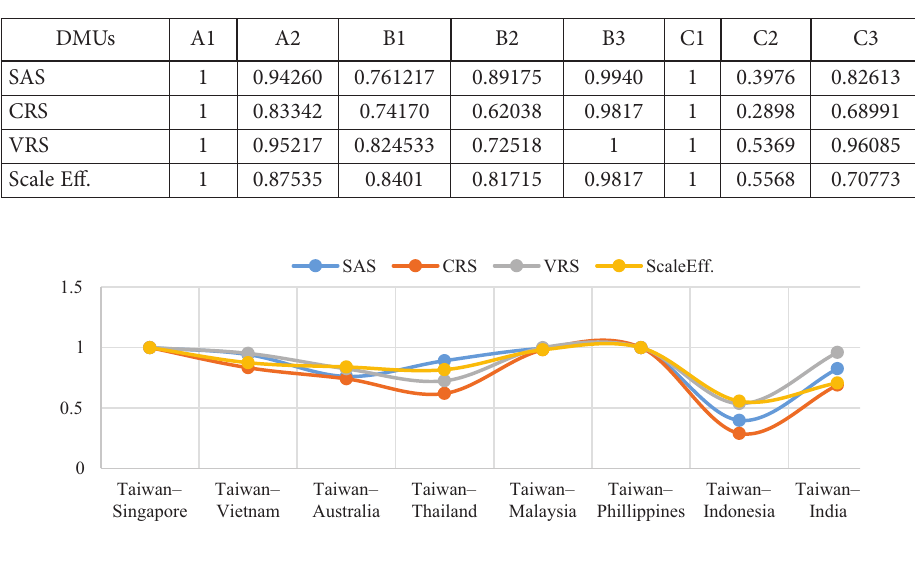
Table 4. Cross-period comparisons between DMUs (source: compiled by the author)